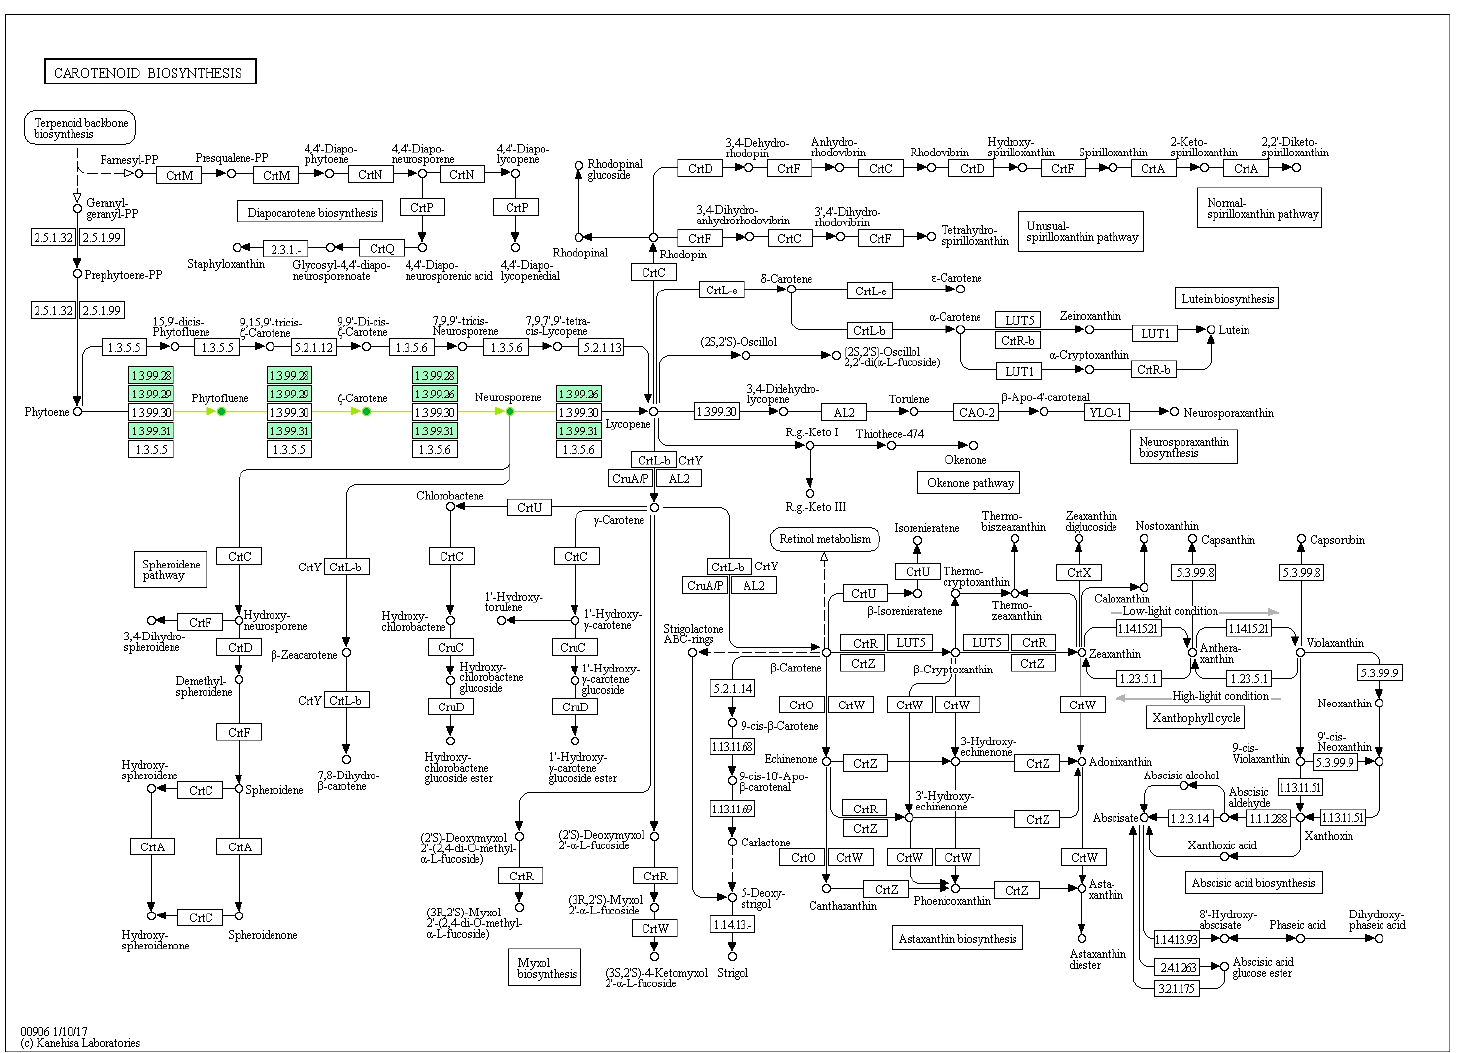
Figure A2. Genes encoding carotenoids identified for Asaia bogorensis (marked in green) by Kawaii et al. (2015) [20]. Adapted from Kawaii et al. (2015) using KEEG mapper. The pathway of phytofluene and neurosporene synthesis is green lines with dark-green markers.